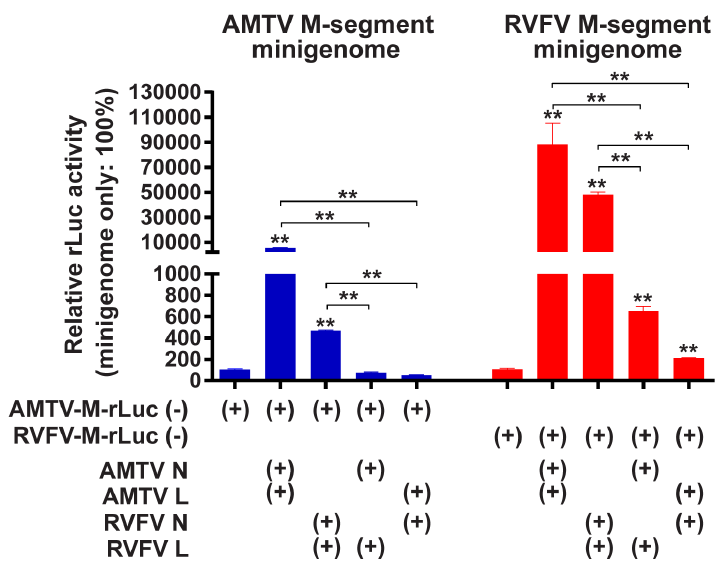
Fig 3. Minigenome assayswith expressions of N and L proteins derived from Arumowot virus (AMTV) or Rift Valley fever phlebovirus (RVFV). BHK/T7-9 cells were transfected with plasmidsexpressingM- segment minigenome RNA from either RVFV or AMTV, and those expressingN or L proteinsderived from either AMTV or RVFV. The RVFV-M-rLuc and AMTV-M-rLuc represent the M-segment minigenomes derived from RVFV and AMTV, respectively. Cell lysates were collectedat 72 hpt, and the ratio of Renilla luciferase (rLuc) activities to firefly luciferase(fLuc) activities derived from pT7-IRES-fLuc (control plasmid)was shown as percentage:i.e., the same type of minigenome without N and L expressionwas set as 100%. Bars representmeans plus standard errors. Asterisks on error bars represent statisticallysignificant increases comparedto samples expressing minigenome only (One-way ANOVA ** p <